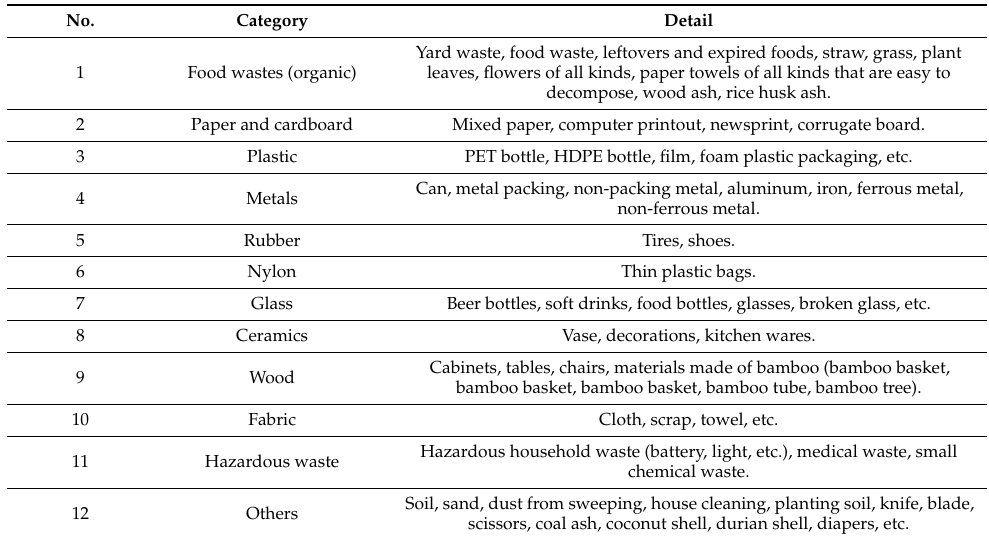
Table 2. Description of HW categories and sub-categories.